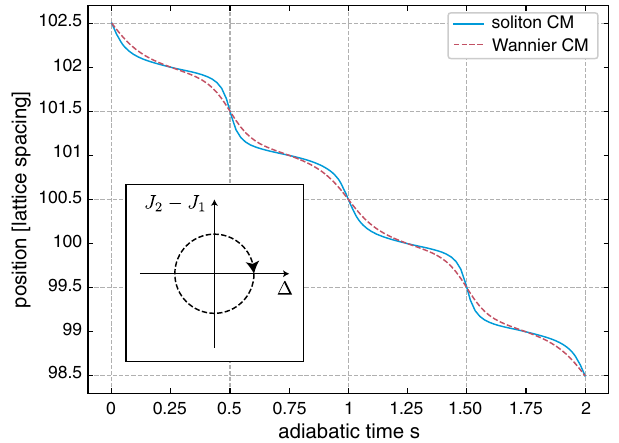
Fig. 3 | Comparison of soliton and Wannier function center-of-mass displace- ment. Adiabatic evolution of the soliton ’ s center-of-mass (CM) during two full pump cycles (inset), as obtained by solving Eq. (3) on the Rice-Mele lattice with g = J 0 , and selecting a soliton in the lowest band. This iscompared to the evolution of the center-of-mass of the Wannier function with largest contribution to the soliton ’ sexpansion[Eq.(4)].Forclarity,theWannierfunctionsarerelabeledduring thepump cyclesuchthattheircenter-of-massfollowsacontiguouspathinsteadof windingaroundaunitcell.ThequantizeddisplacementissetbytheChernnumber C = − 1 of the occupied